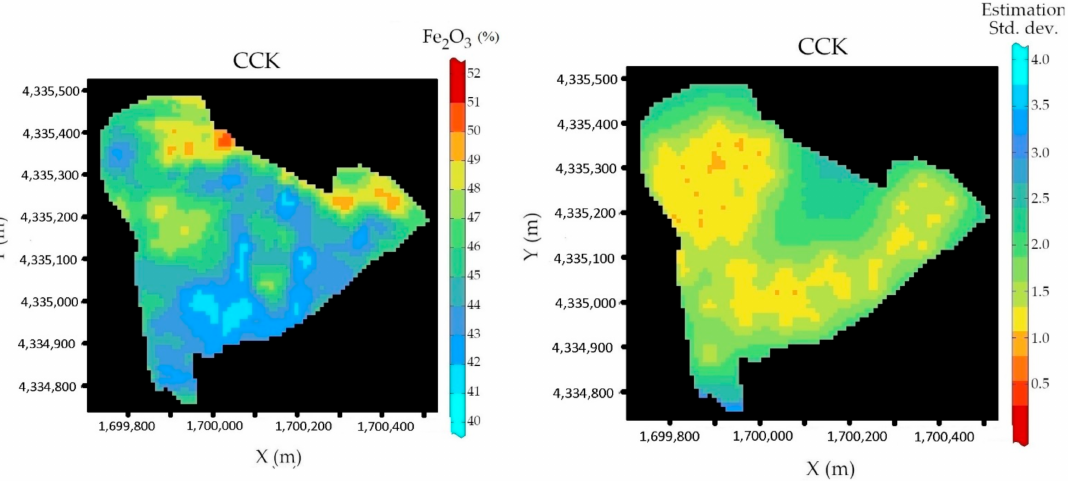
Figure 10. Fe 2 O 3 (%) estimated map ( CCK ) ( left ) and the estimation variance map ( right ), by performing CCK between iron samples and the first component of ferrous iron oxide band ratio (Range = 70